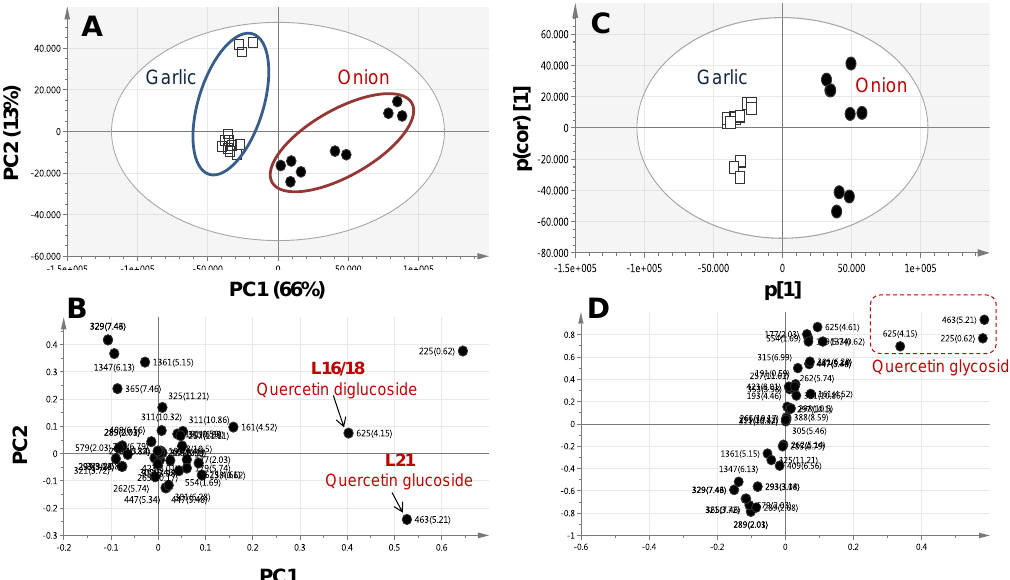
Figure 4. Principal component analysis (PCA) and orthogonal projection to latent structures-discriminant analysis (OPLS) supervised data analysis of modelling A. sativum versus A. cepa red cv. specimens analysed via UPLC-MS for their secondary metabolites. PCA score ( A ) and loading plot ( B ) ( n = 3); OPLS-DA score plot ( C ) and loading S-plot ( D ). Segregation in both score plots shows enrichment of sulphur compounds in A. sativum versus flavonoids in A. cepa red cv. Peak numbering follow that listed in (Table 2) for metabolite identification via UPLC-MS.